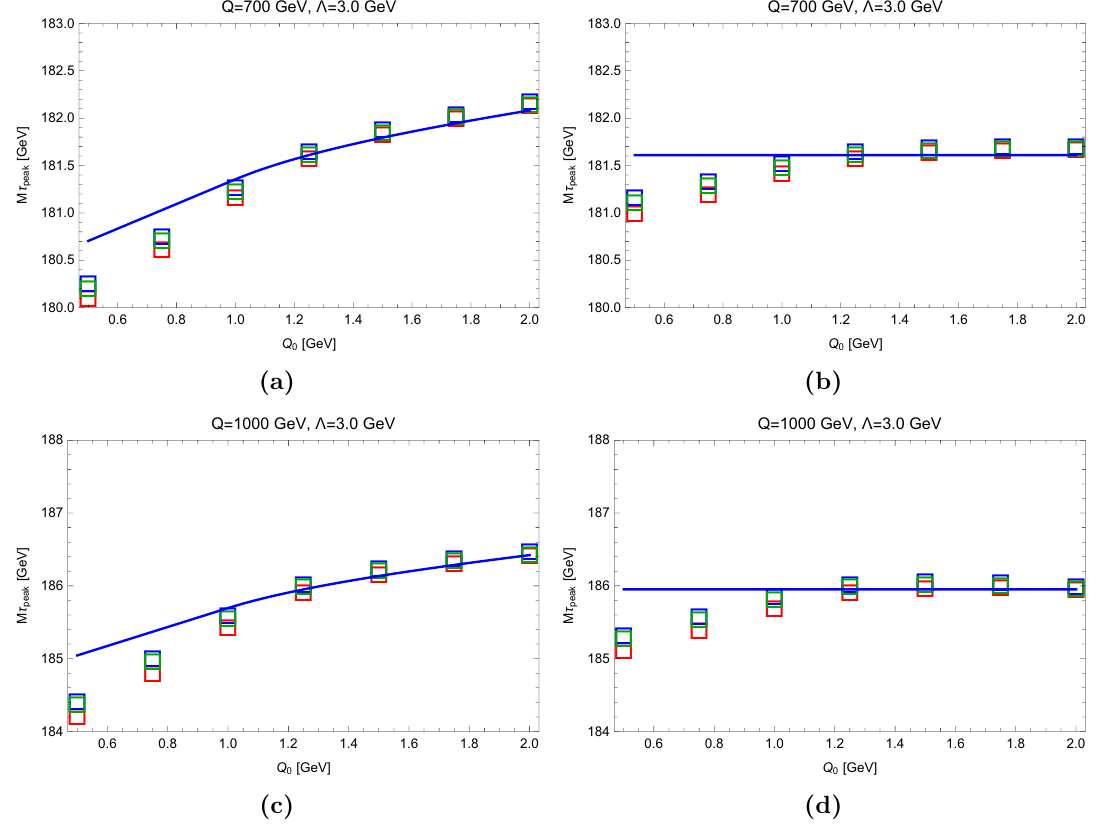
Figure 13. Peak position M (cid:28); peak at the parton level obtained from Herwig 7 for the top quark generator mass m t = 173 GeV as a function of the shower cut Q 0 for Q = 700 GeV (upper panels) and Q = 1 TeV (lower panels) for smearing with (cid:3) = 3 GeV. Left panels: in addition to the results shown in (cid:12)gure 12 we have included the soft function gap calculated analytically to remove the shower cut dependence due to the large angle soft radiation. Right panels: in addition to the results of the left panels we have set the generator mass to m CB ( Q 0 ) such that the peak position becomes independent of the shower cut Q 0 . The blue solid line represents the corresponding analytic prediction for the remaining cuto(cid:11) scale dependence. For all results we used Q 0 reference